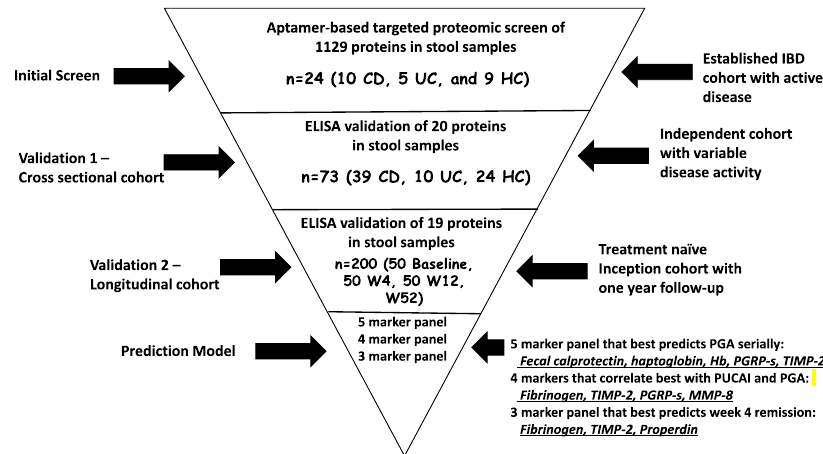
Fig. 1 An overview of the study showing the discovery of panels of stool proteins arising from an initial aptamer-based screen. This consort diagram shows how the initial screen consisting of 1129 proteins were narrowed down to 19 stool proteins during validation. Various prediction models identi fi ed MMP-8 correlate best with concurrent PUCAI and PGA scores, a 5-marker panel (Fecal calprotectin, haptoglobin, Hb, PGRP-s, and TIMP-2) best